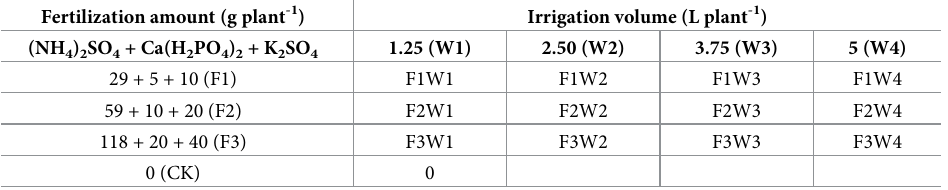
Table 1. Fertilizer–water coupling experimental design (single